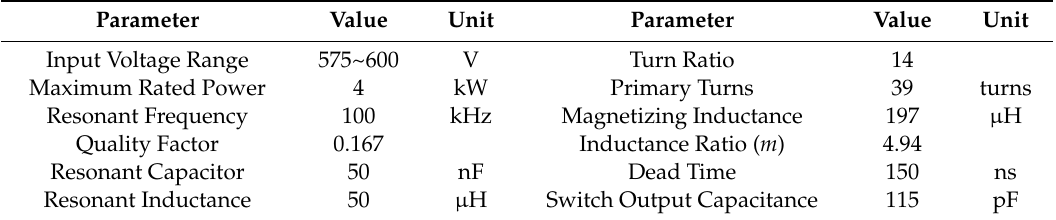
Table 1. Simulation parameters.